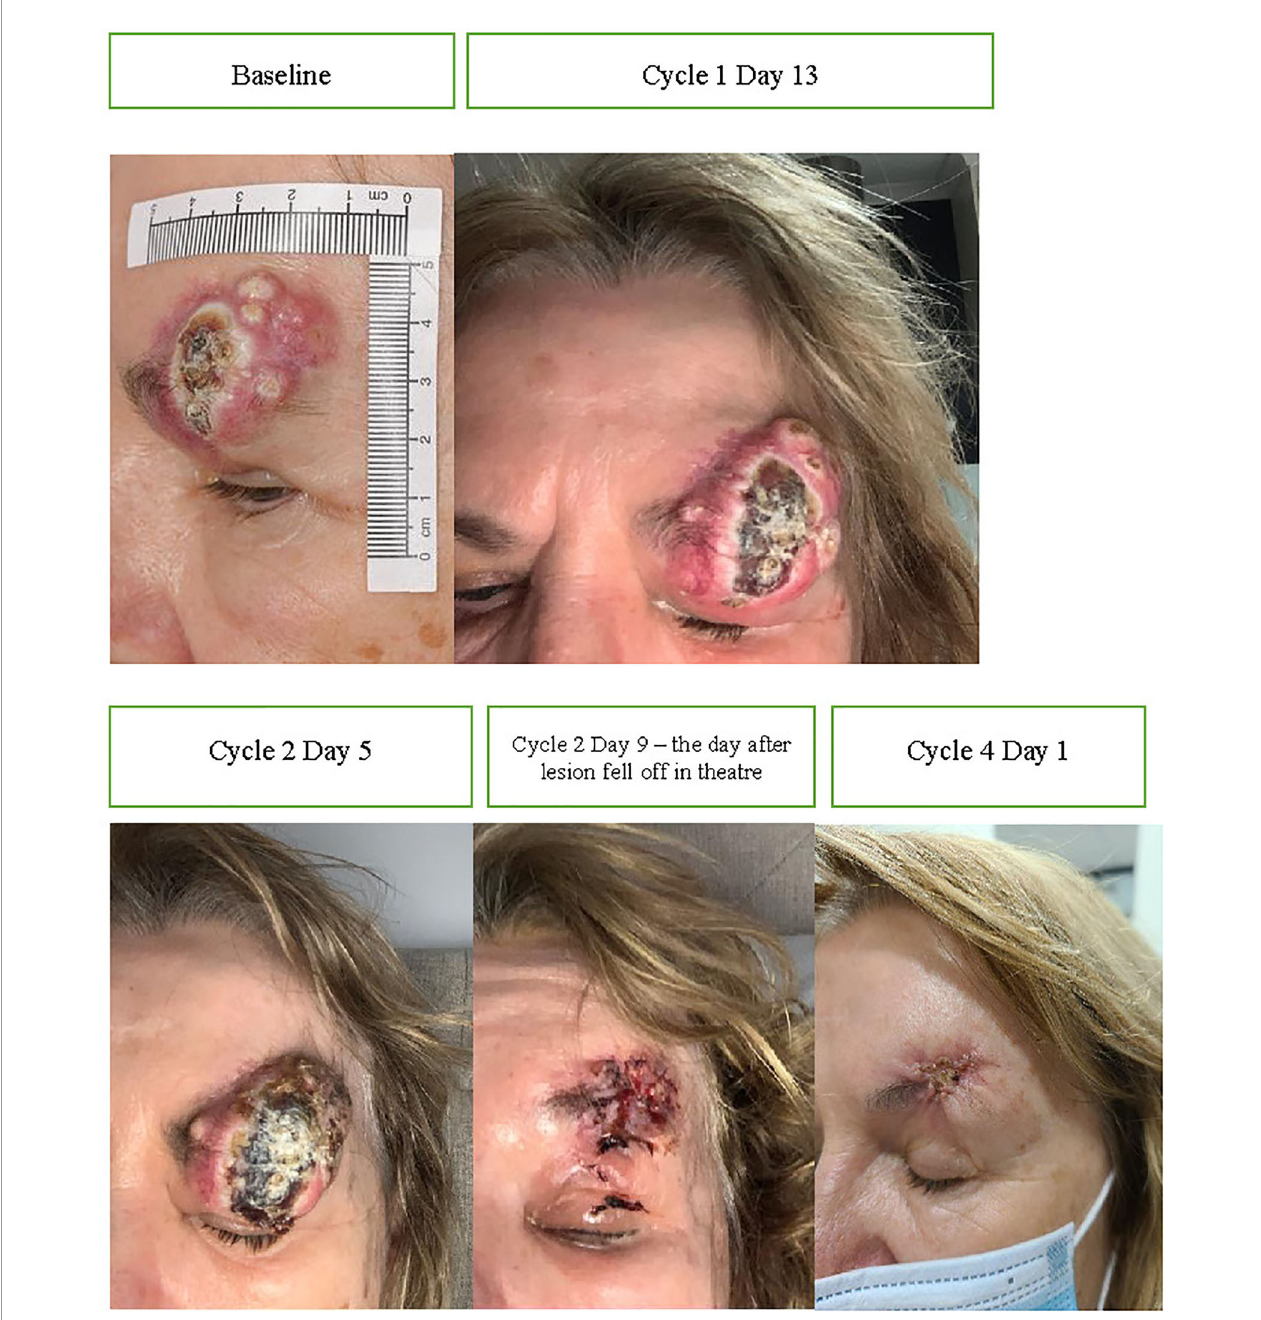
FIGURE 5 | Baseline images of CSCC and throughout initial treatment demonstrating enlargement post commencement of cemiplimab 350 mg/3-weekly (consistent with pseudoprogression) and improvement after the lesion fell at off the time of